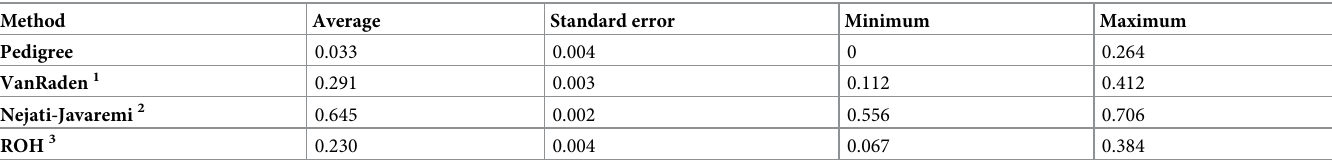
Table 1. Estimates of inbreeding for the genotyped British Lop animals.